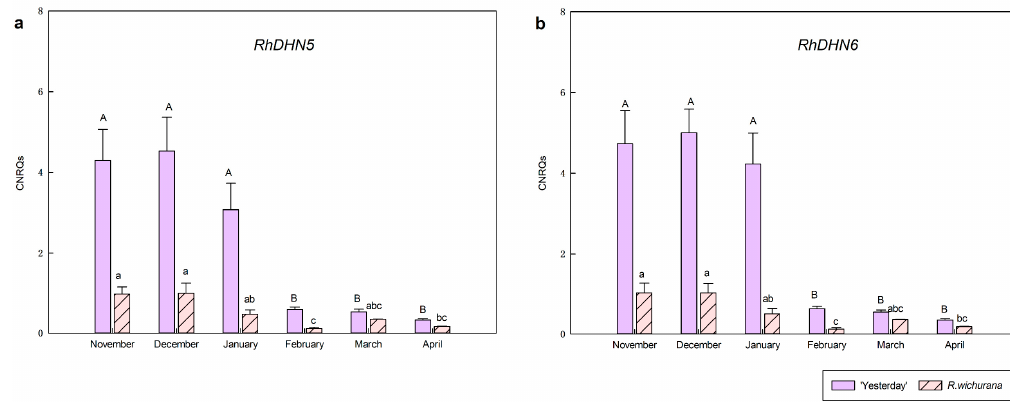
Figure 2. Seasonal changes in expression of dehydrins including RhDHN5 ( a ) and RhDHN6 ( b ) in the more cold ‐ hardy genotype ( Rosa hybrida ‘Yesterday’) and the less cold ‐ hardy genotype ( R. wichurana ). Data were assessed by one ‐ way ANOVA and a Scheffé post ‐ hoc test ( p = 0.05). Different letters (A, B, etc.; or a, b, etc.) indicate significant differences between time points within each genotype. Normalized relative quantities (CNRQs, non ‐ log ‐ transformed) are presented as geometric means ± SE ( n = 3).